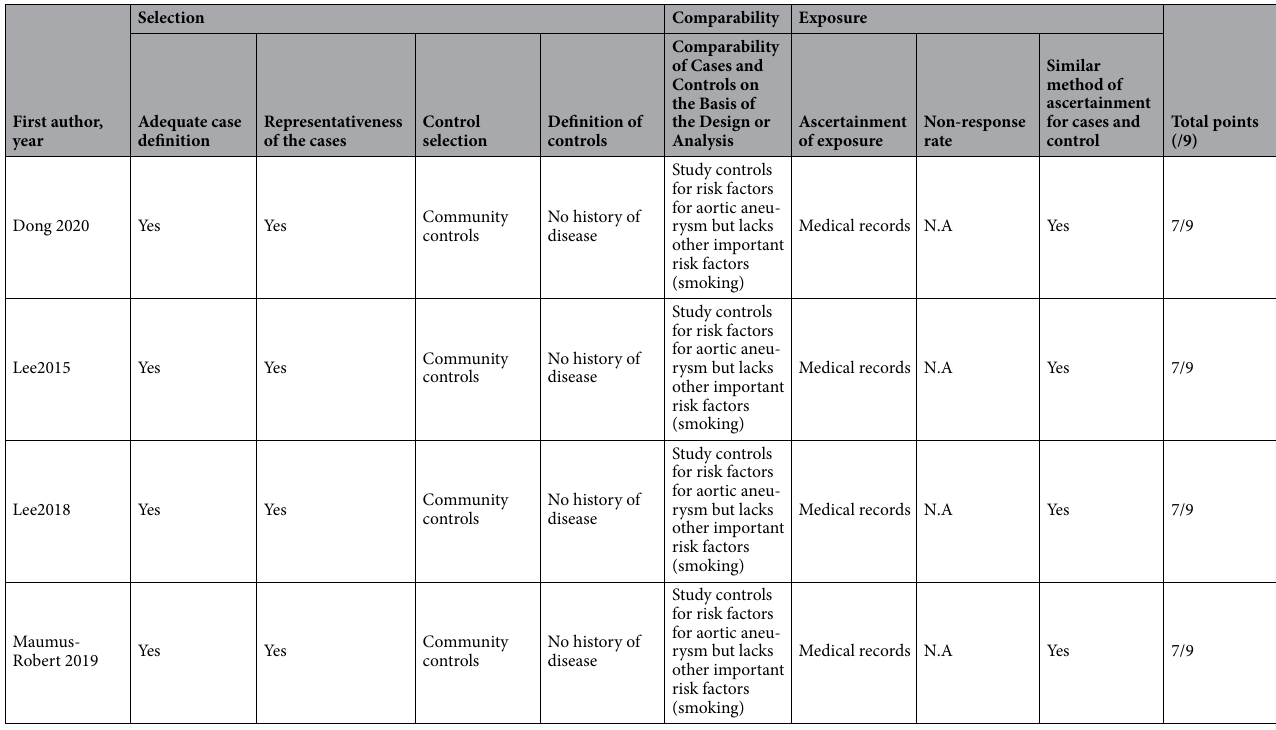
Table 3. Risk of bias assessment for case–control studies.